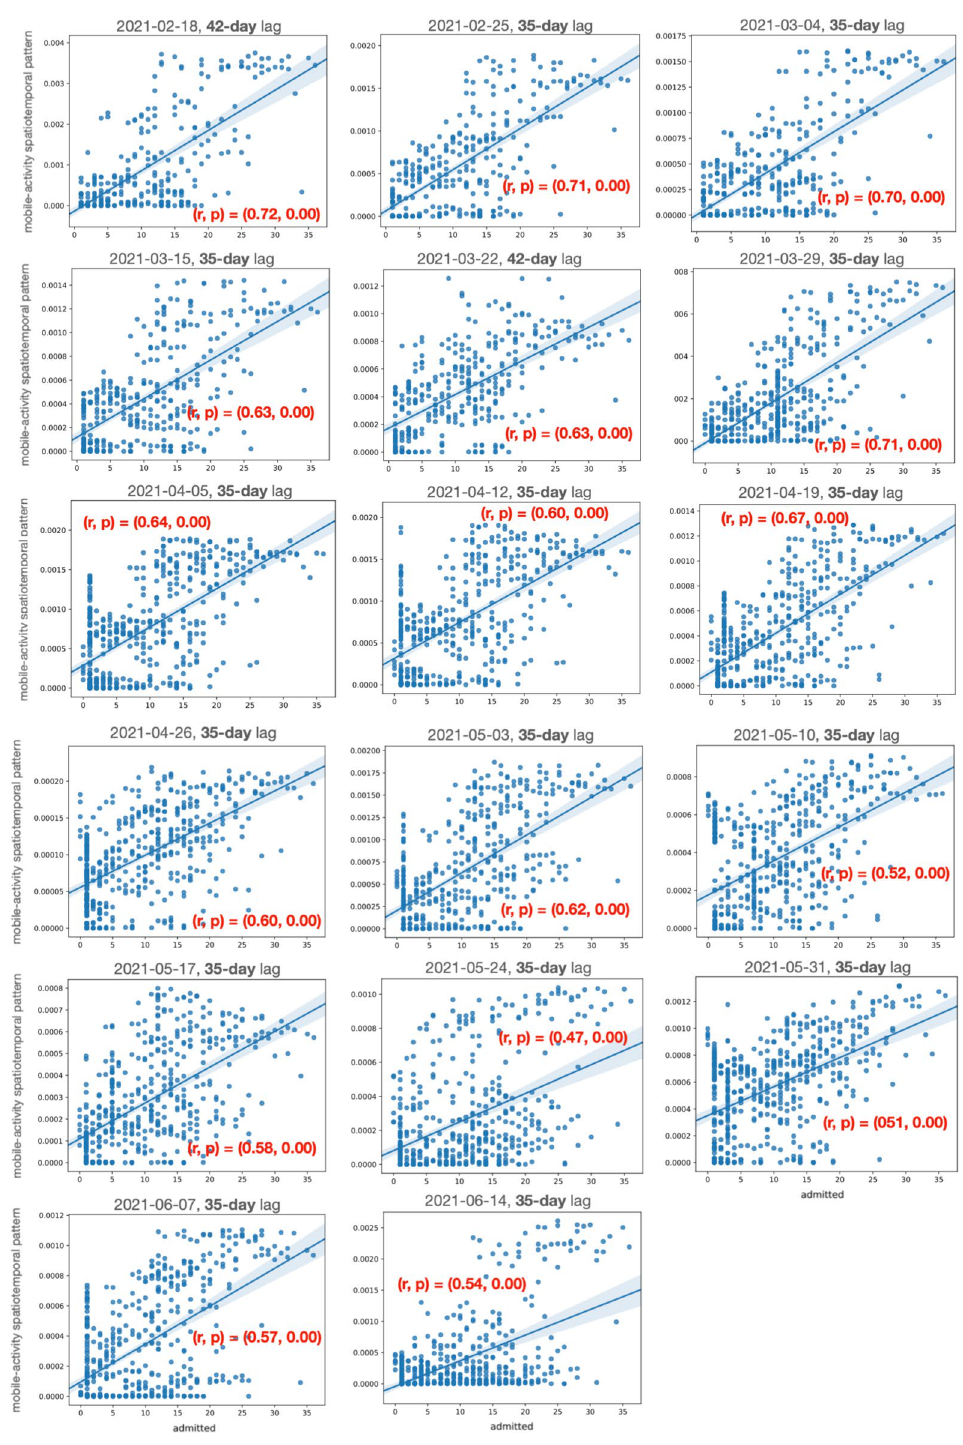
Figure 4. Pearson correlation between the positively correlated spatiotemporal component and the daily number of admitted patients at SU. The positively correlated spatiotemporal components are extracted from mobile activity data by the spatiotemporal model. The figure shows the correlation (r) score and the statistical significance (p) score across various analysis dates. The figures also show the optimal time lag at which the Pearson correlation between the spatiotemporal components and daily number of admitted COVID-19 patients is at its highest value. The optimal time lag is 35 days for all analysis dates except for 2021-02-18 and 2021-03-22 which is 42